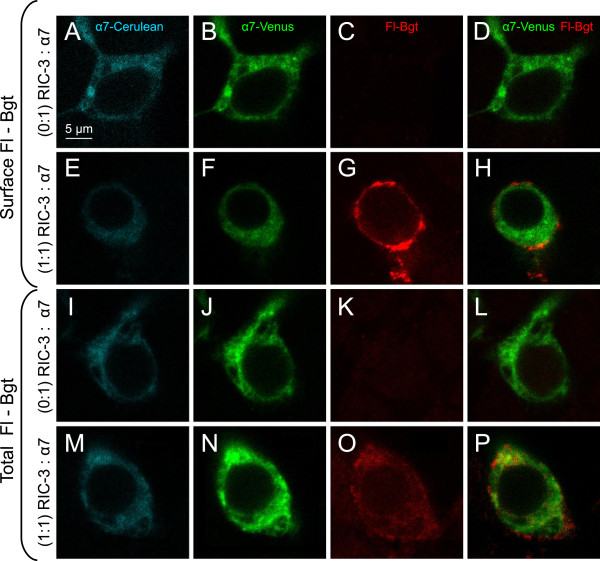
RIC-3 increases whole cell and cell surface expression of α-Bgt binding sites. Spectral confocal microscopy images of α-Bgt binding assays using Alexa 648 α-Bgt (Fl-Bgt) and performed under nonpermeabilizing conditions (A, B, C, D) without RIC-3, or (E, F, G, H) with RIC-3 (1:1 to α7), and permeabilizing conditions (I, J, K, L) without RIC-3 and (M, N, O, P) with RIC-3 (1:1 to α7). Emission signals from α7-Cerulean, α7-Venus, Fl-Bgt binding sites and the merged α7-Venus / Fl-Bgt images are shown for each corresponding cell. RIC-3 increases surface and intracellular α-Bgt binding sites.